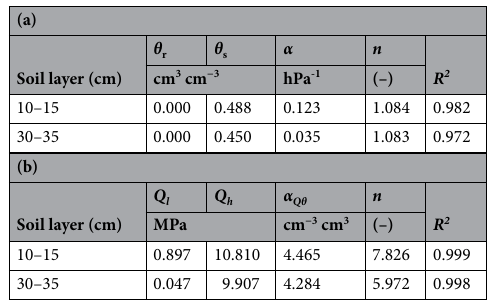
Table 10. Parameters of van Genuchten 35 model for the SWRC (a) and modified van Genuchten 35 model for the SPRC (b) fitted to the measured data. θ r and θ s : residual moisture and soil saturation, respectively; α : inverse suction in the turning point (air entry point); n : pore size distribution index; Q l and Q h : lowest (wet) and maximum (dry) predicted soil penetration resistance, respectively; α Qθ and n Qθ : fitness parameters of the model related to the turning point and slope of the mechanical strength function against soil water; R 2 is coefficient of determination.